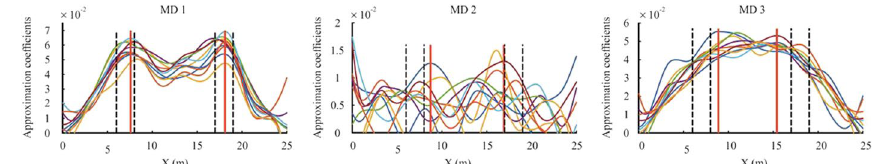
Fig. 19 The ninth order approximation coefficient curves of the signal along the X axis for 3 multiple damage scenarios in the presence of noise